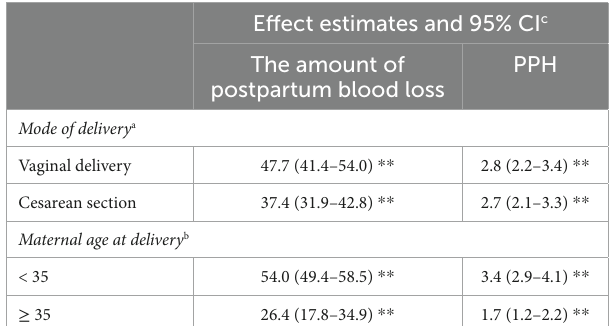
delivery, newborn birth weight and placental abnormality. ** p < 0.01. TABLE 4 Adjusted associations between the use of IVF/ICSI and the amount of postpartum blood loss or risk of PPH stratified by mode of delivery or maternal age at